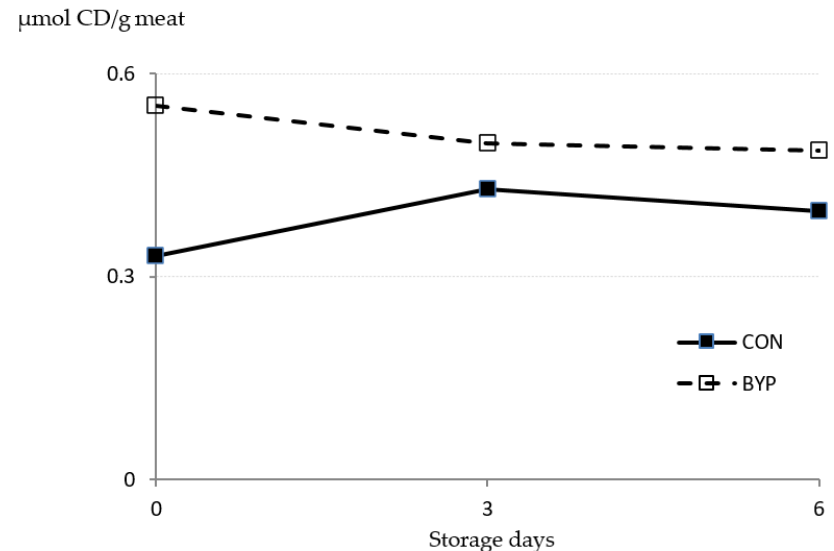
Figure 2. Effect of the dietary treatment (CON and BYP) and storage time (0, 3, and 6 days) on the concentration of conjugated dienes (CD; expressed as µmol/g meat) measured in lamb meat stored in unmodified atmosphere at 2 °C: in repeated measures ANOVA, values of p were 0.219, 0.642, and 0.740 for diet, time, and diet × time interaction, respectively, and standard error of the mean (SEM) values were 0.0265 and 0.0325 for diet and time effects, respectively.